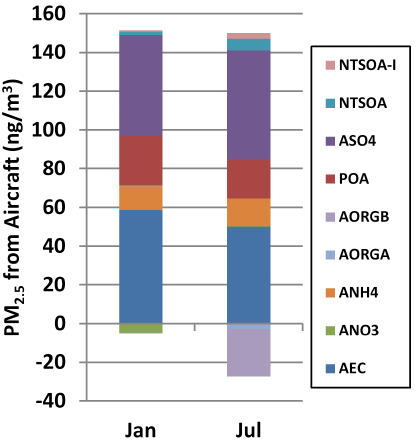
Figure 3. Box-and-whisker plots showing the 25th, 50th (red line), and 75th percentiles and minimum and maximum values of daily average aircraft-attributable PM 2 . 5 , non-typical SOA (NTSOA), and traditional SOA (TSOA) in the grid cell containing ATL. Out- liers are defined as values more than 1.5 times the interquartile range above the 75th percentile and below the 25th